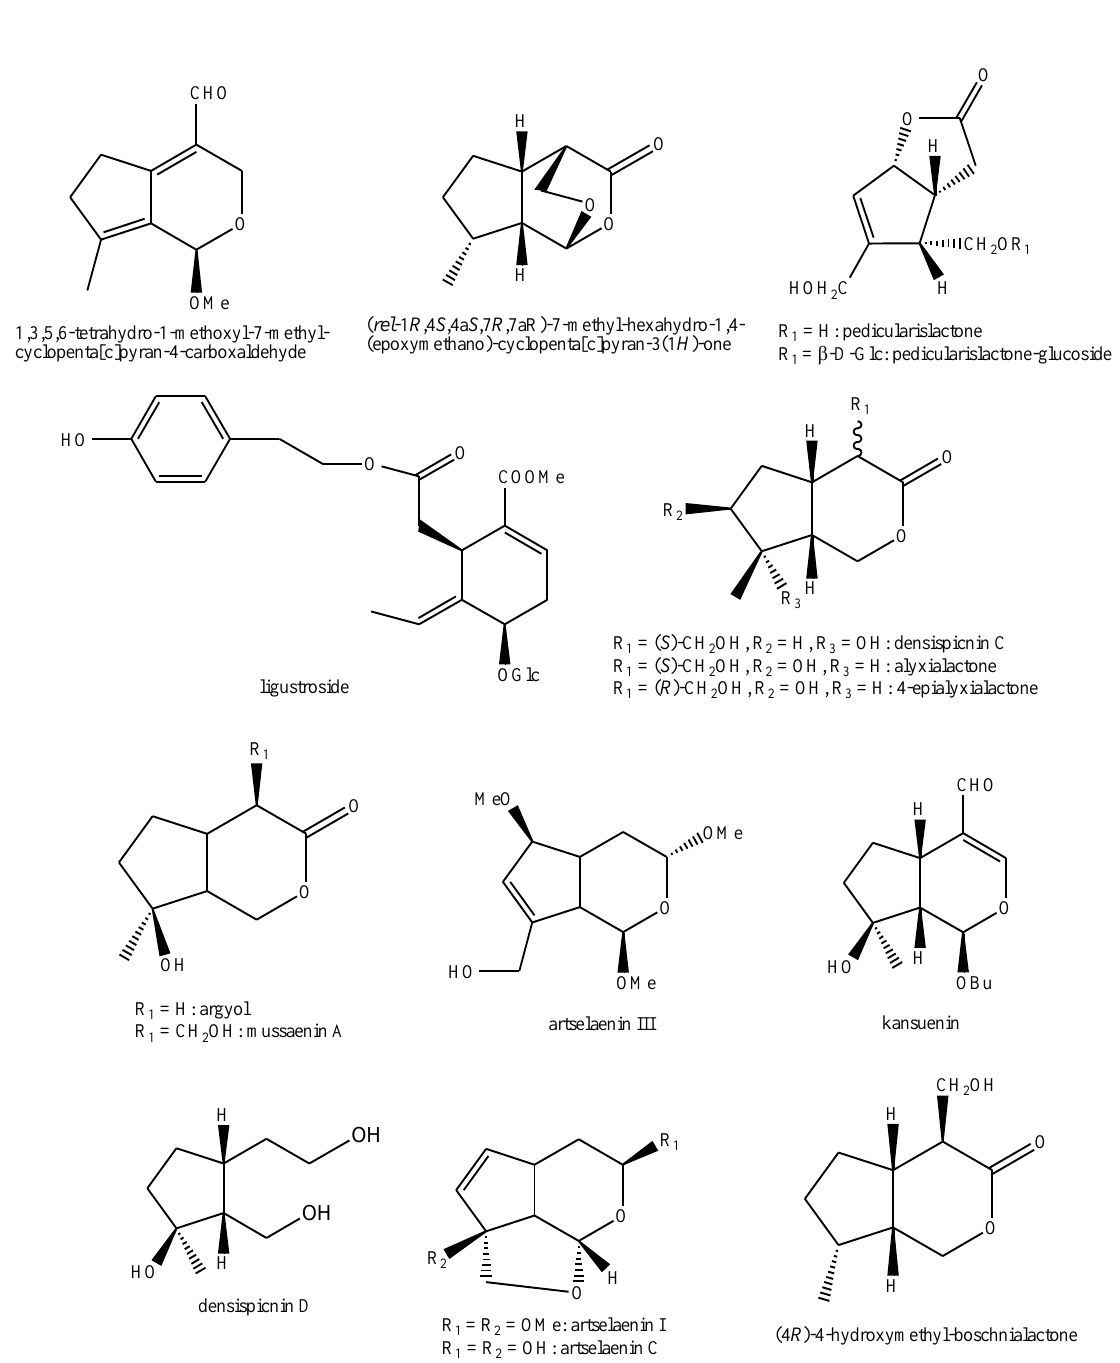
Figure 19 . Iridoids identified in Pedicularis species—part 5. Figure 19. Iridoids identified in Pedicularis species—part